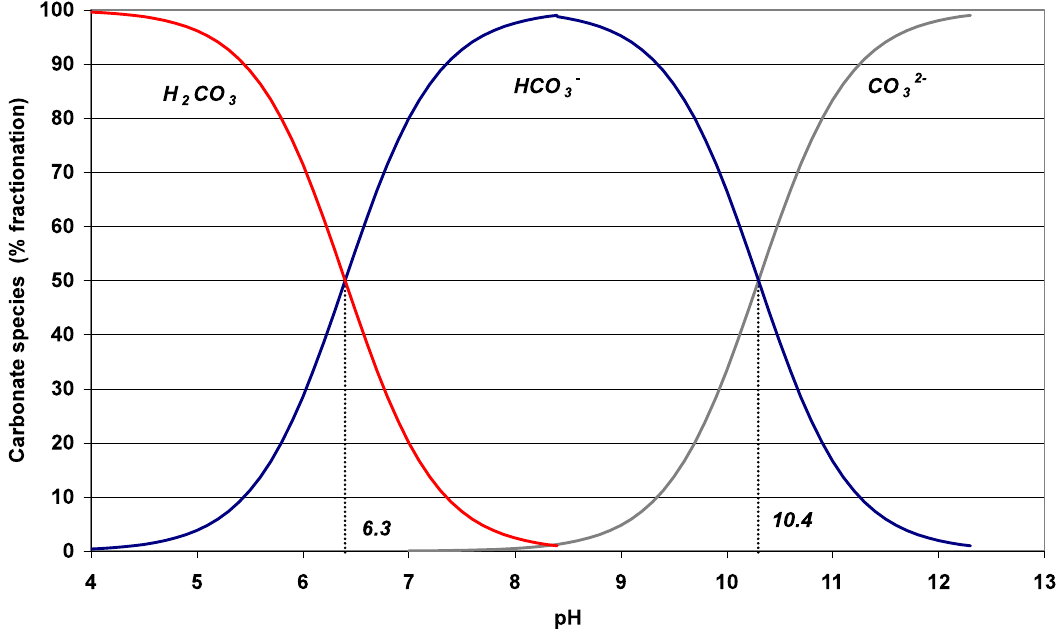
Figure 1. Stability fields of the carbon species (as indicated) in pure water on the basis of the water pH. The pHs of 6.3 and 10.3 (vertical dotted lines) indicate the inflection points, where the ratios of the carbon species are equal to 1.0 (for the H